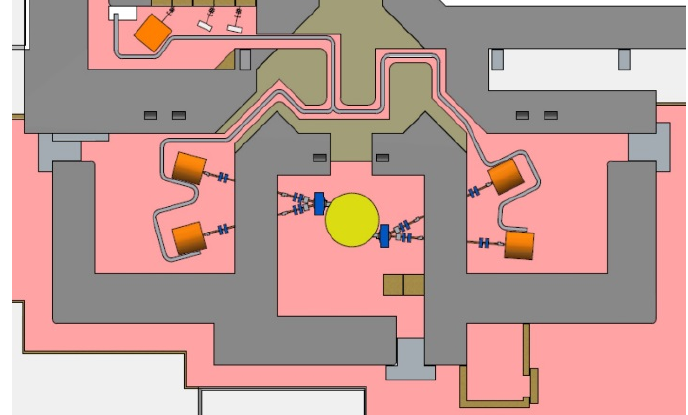
Figure 2. Layout of the ACE Isotopes facility, showing the cyclotron vault (middle), production vaults (left and right) and the expanded Telelift target transport